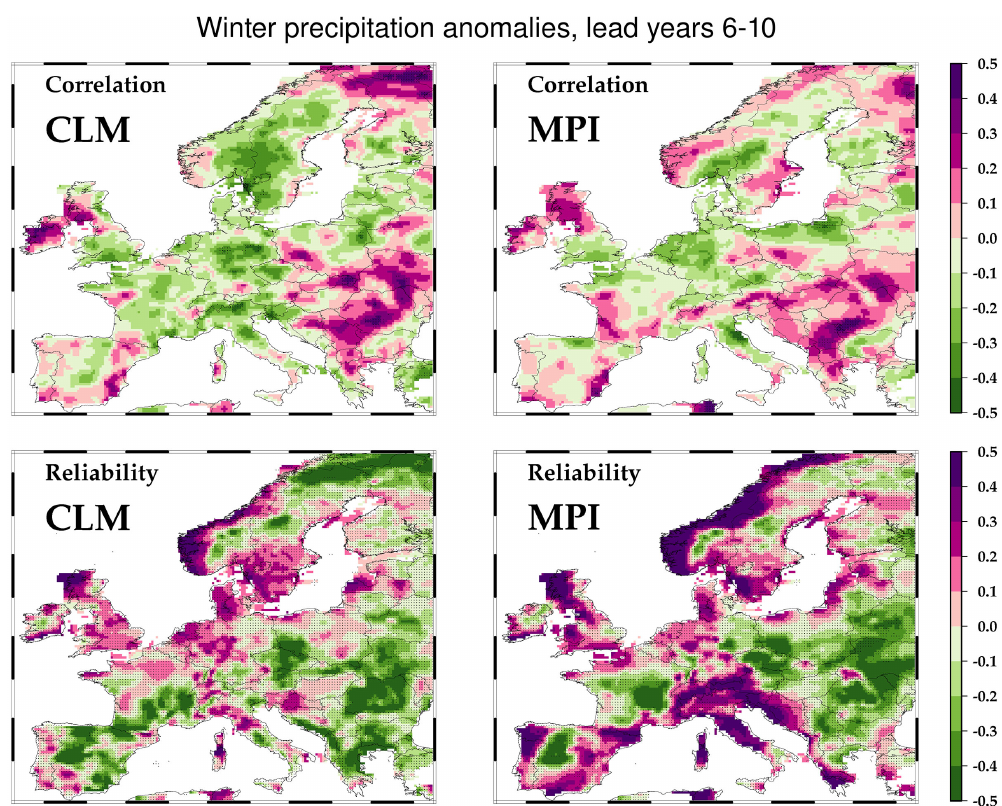
Figure 8. Winter half-year precipitation anomaly sums for lead years 6–10 from 1961 to 2010. The top panels show the correlation coefficient between E-OBS observations and CCLM (left) and MPI-ESM-LR (right). The bottom panels show the reliability of the CCLM (left) and MPI-ESM-LR (right) ensembles with respect to the E-OBS observations. Stippling indicates results, significant at the 10%